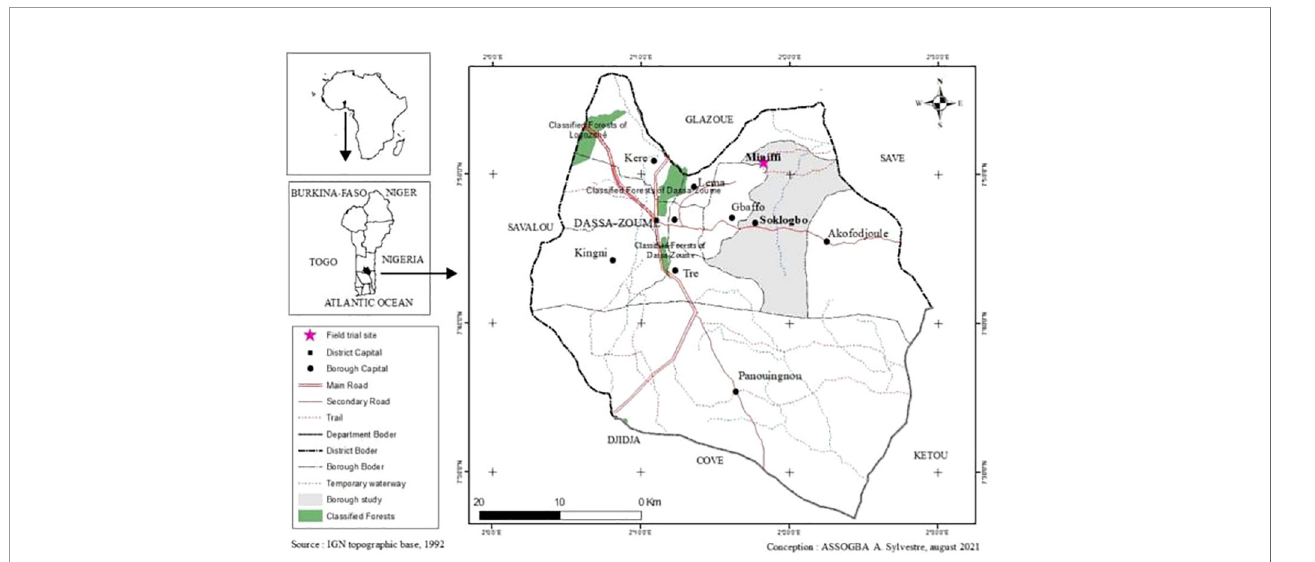
FIGURE 1 | Geographical location of the Minif fi experimental